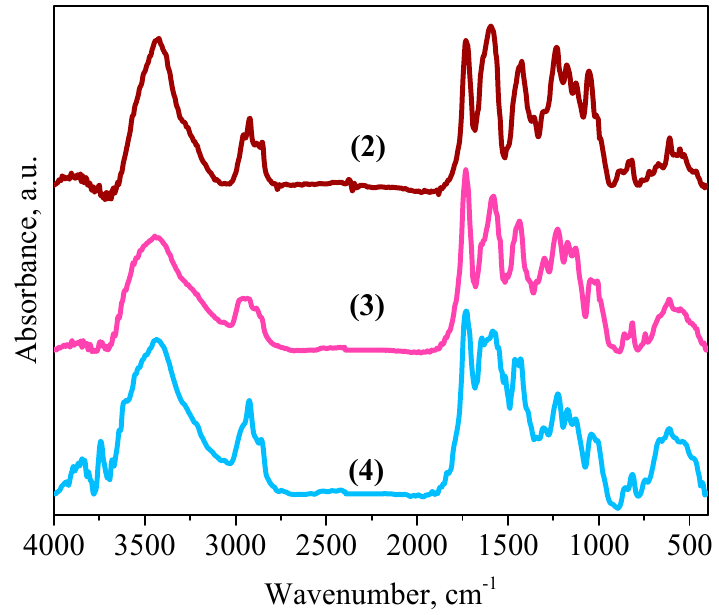
Figure 5. IR spectra of sodium salt 2 and Gd(III) 3 and Dy(III) 4 complexes .